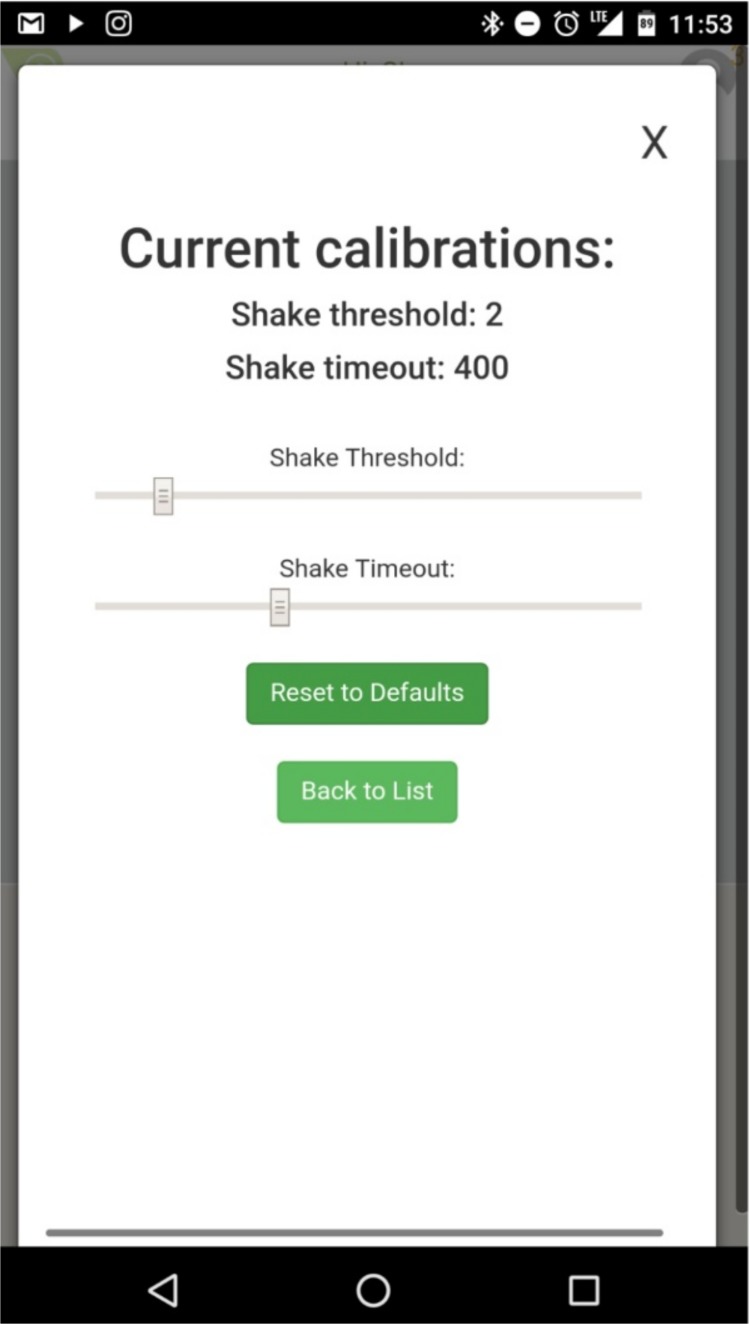
The interface for modifying shake service parameters is shown.The shake threshold relates to the amplitude required to register as an event and shake timeout which provided a window where a single event could be counted.